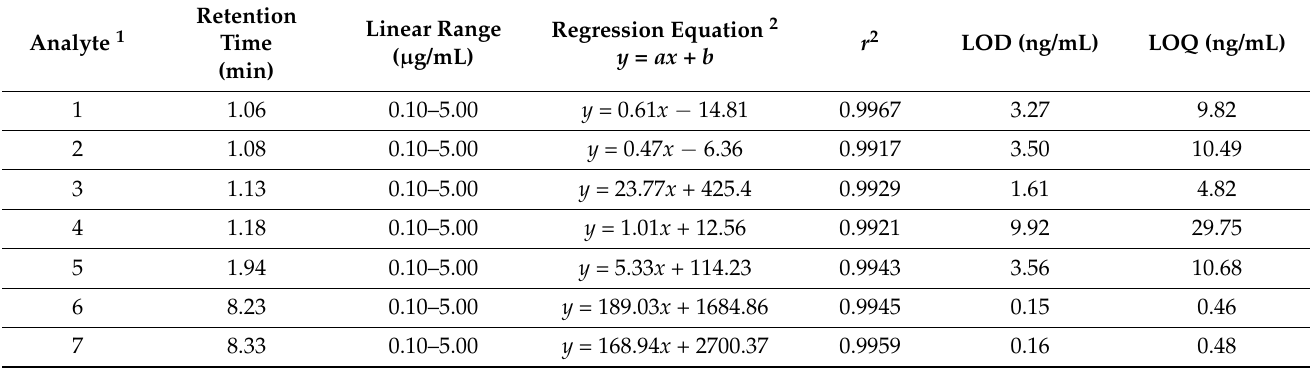
Table 6. Retention time, linear range, regression equation, r 2 , LOD, and LOQ values for simultaneous determination of the seven analytes using the UPLC–MS/MS method.